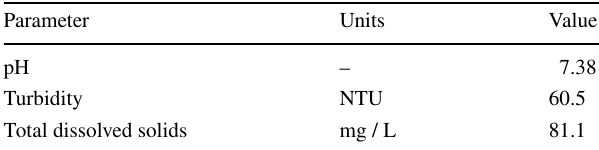
Table 1 Characteristics of wastewater sample Parameter